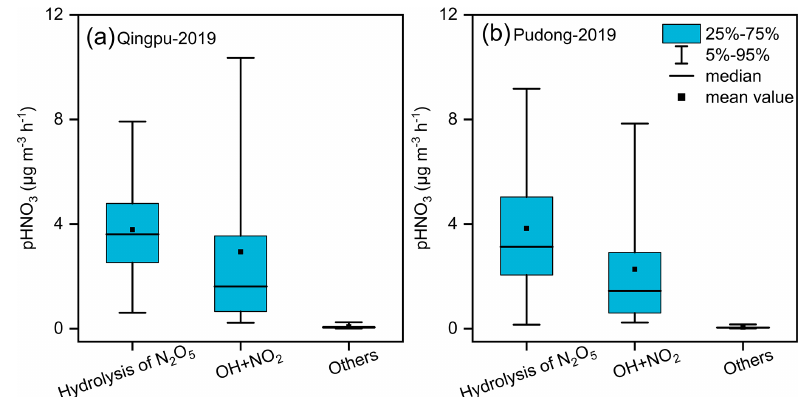
Figure 9. Simulated average formation rates of HNO 3 at (a) Qingpu and (b) Pudong sites during the haze pollution periods in 2019.